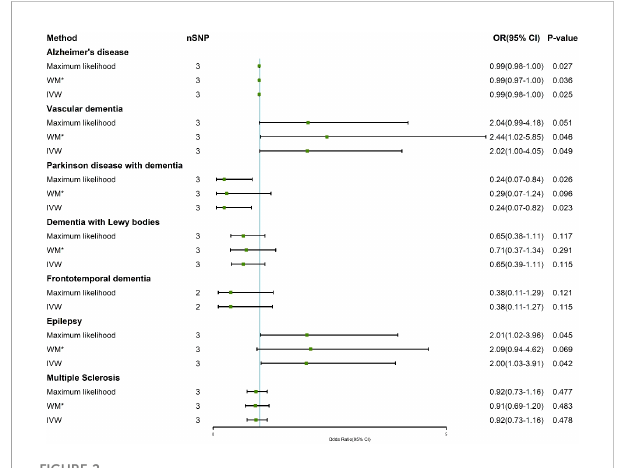
FIGURE 2 Association of genetically determined plasma cortisol and outcomes using the IVW, weighted median and maximum likelihood methods. IVW, inverse variance weighted; WM*, weighted median; OR, odds ratio; CI, con fi dence interval; SNP, single nucleotide